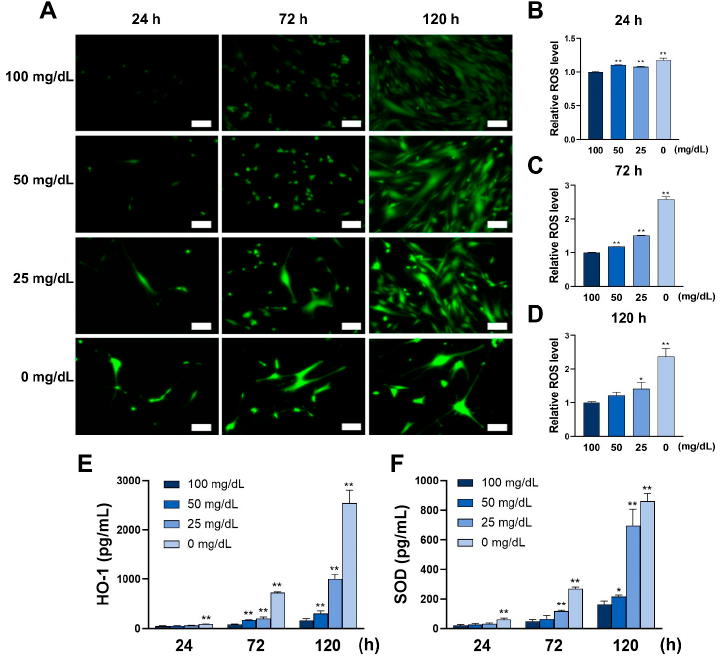
Figure 1. Low glucose conditions induce ROS by impairing the anti-ROS capacity of human gingival fibroblasts (HGnFs). ( A ) After 24, 72, and 120 h of incubation, the HGnFs were stained for total ROS evaluation using a ROS detection kit (Nacalai) and photographed under a fluorescent microscope. ( B – D ) The levels of total ROS at 24, 72, and 120 h were measured using a fluorescent microplate reader, and the results were modified relative to 100 mg/dL (control group). ( E –F) The expression of SOD and HO-1 was determined using ELISA in supernatants of stimulated HGnFs incubated for 24, 72, and 120 h. (Scale bars: 100 μ m; a significant increase compared with the control was described as * p < 0.05, ** p < 0.01).